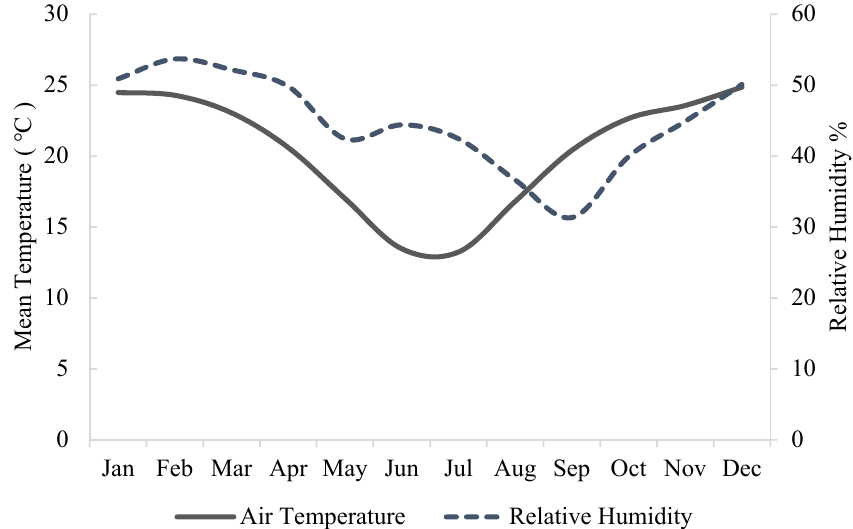
Figure 2. Temperature and relative humidity profile in Ga-Rankuwa.